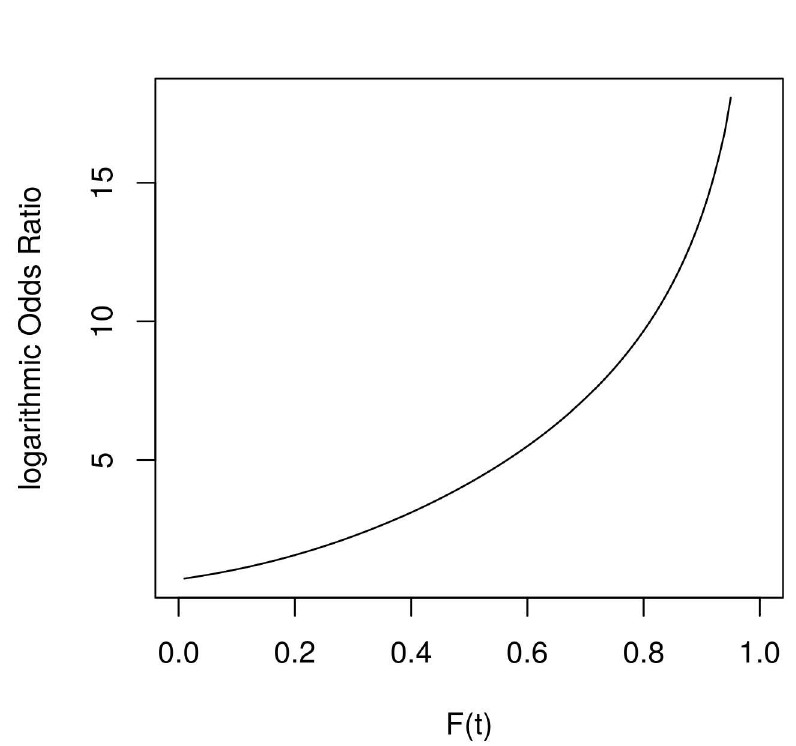
Fig 2. OR Diagram comparing 1 and 2 processors. Using 6